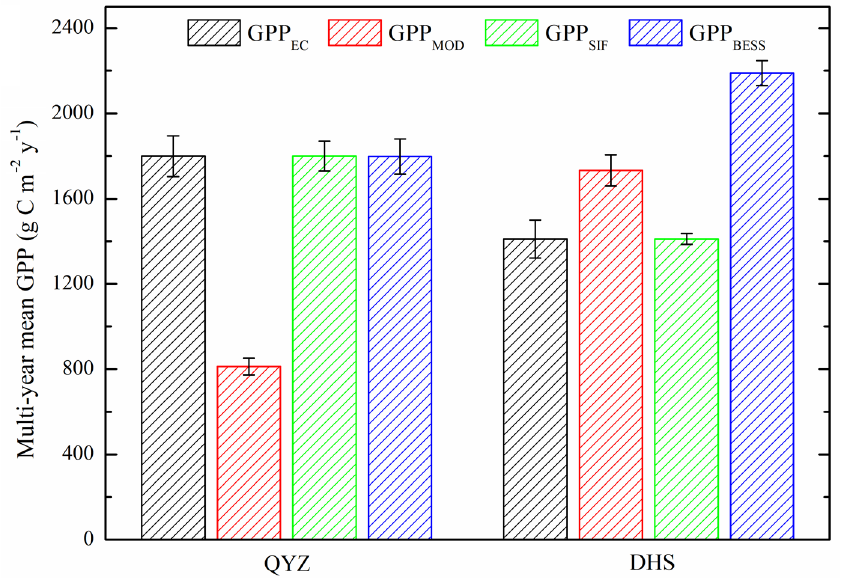
Figure 9. Comparisons of multi-year mean tower-based GPP observations (GPP EC ) and three different satellite-based GPP products including the SIF-based GPP (GPP SIF ), MODIS GPP (GPP MOD ) and BESS GPP (GPP BESS ) at the two subtropical forest flux sites (QYZ and DHS) during 2003 and 2010. The error bars represent ±1 standard error.